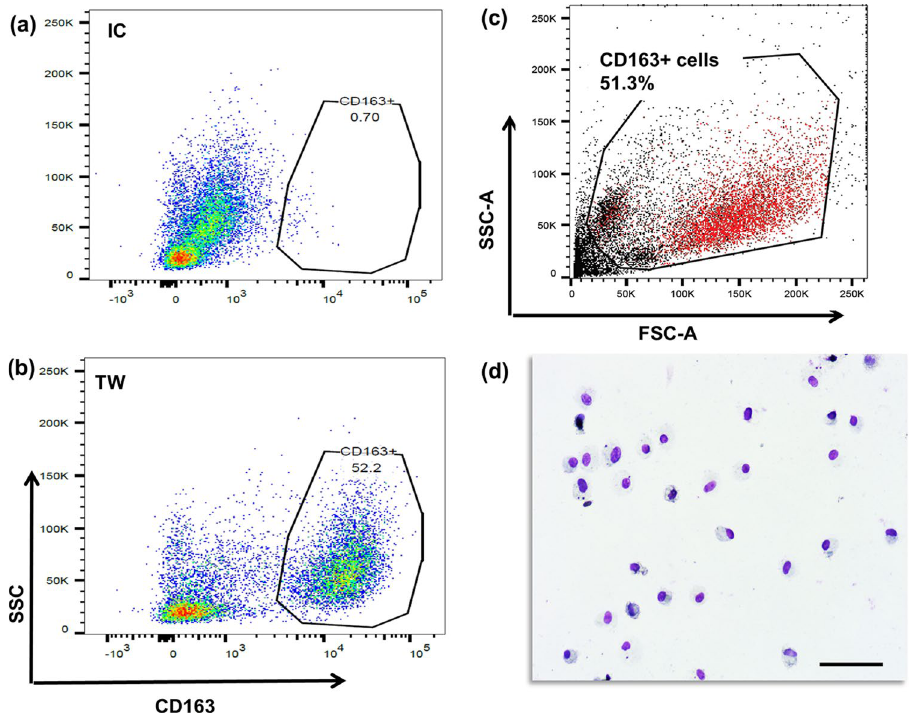
Figure 2. Analysis of tracheal wash derived macrophages. Flow cytometry results showing cross-reactivity of mouse anti-human CD163 antibody against equine tracheal macrophages. (a) Isotype control, (b) CD163 stained cells (c) overlay of CD163+ population on top of total cells. (d) Leishman stained cytospin preparations of CD163+ cells by light microscopy (× 20, scale bar = 50 μm). Data and image analysis was performed in FlowJo ® v10.5.3 https:// www. flowjo.